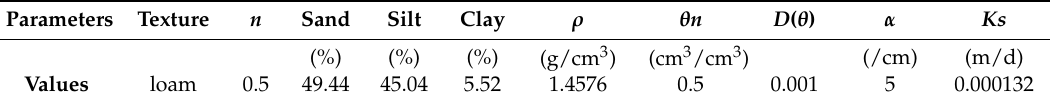
Figure 1. Location of observation station and schematic diagram of monitoring instrument distribution. Table 1. Soil properties: texture (content of sand, silt, and clay), bulk density, saturated water content, saturated hydraulic conductivity, and the fitting parameters to soil water retention curve at this site.